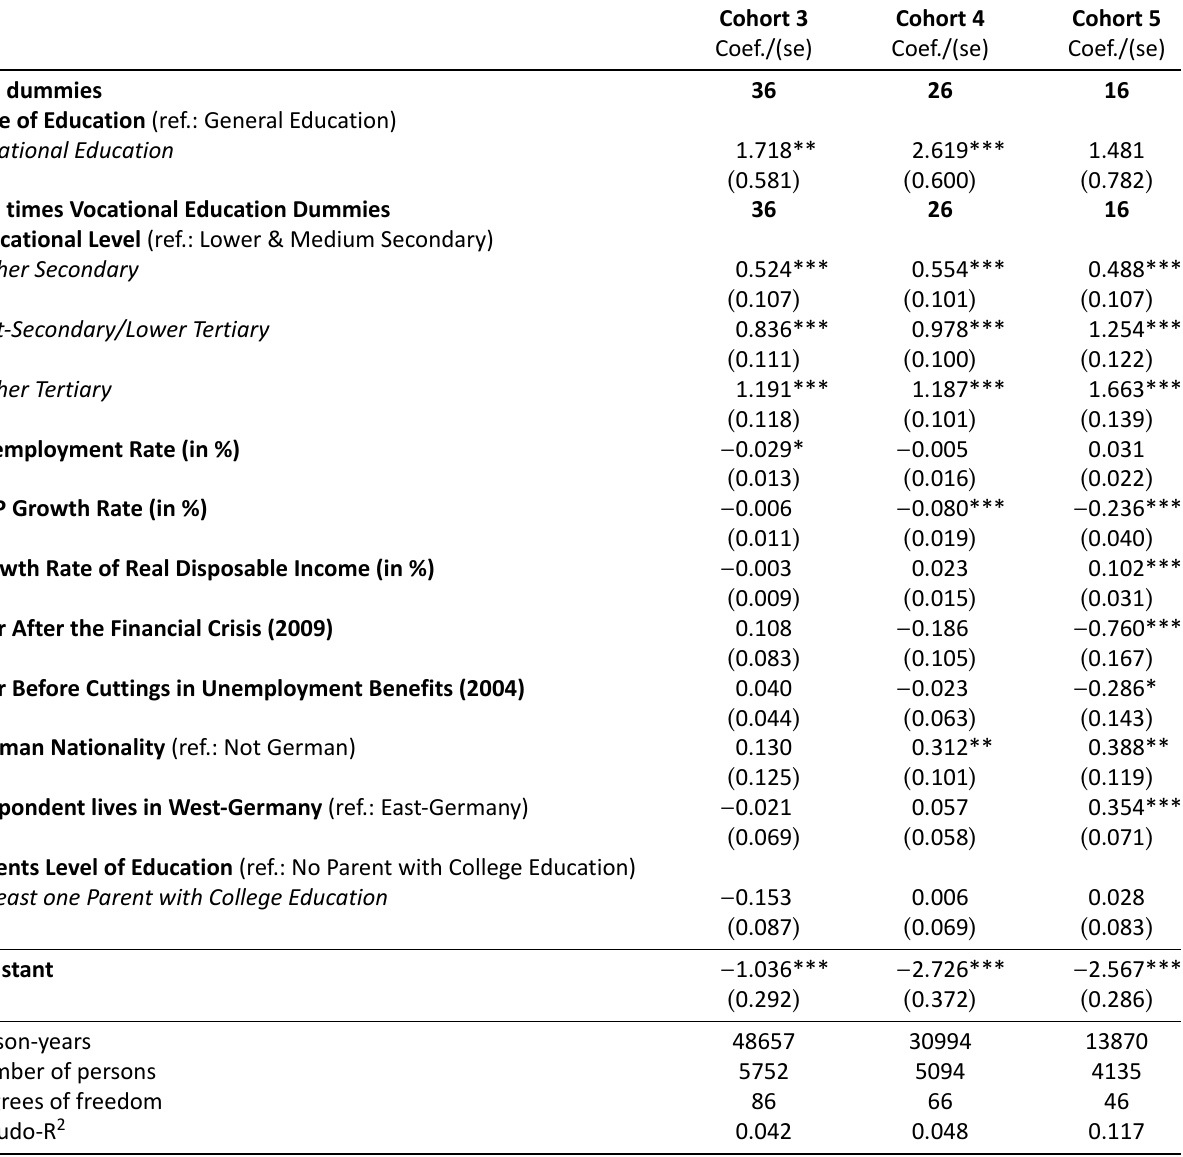
Table A6. Employment opportunity over the life course: General versus vocational education by cohort (women). Data source: GSOEP